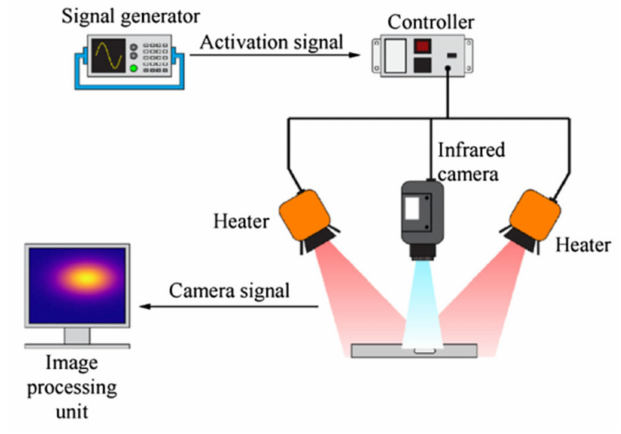
Figure 2. Setup of infrared thermography (IRT) [14].